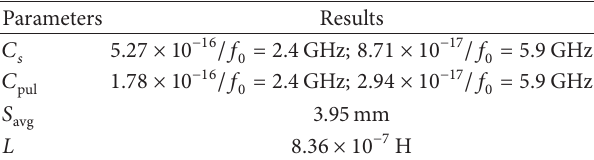
Table 2: Parameters of the CTSRR equivalent circuit. Table 3: Final optimized results of the